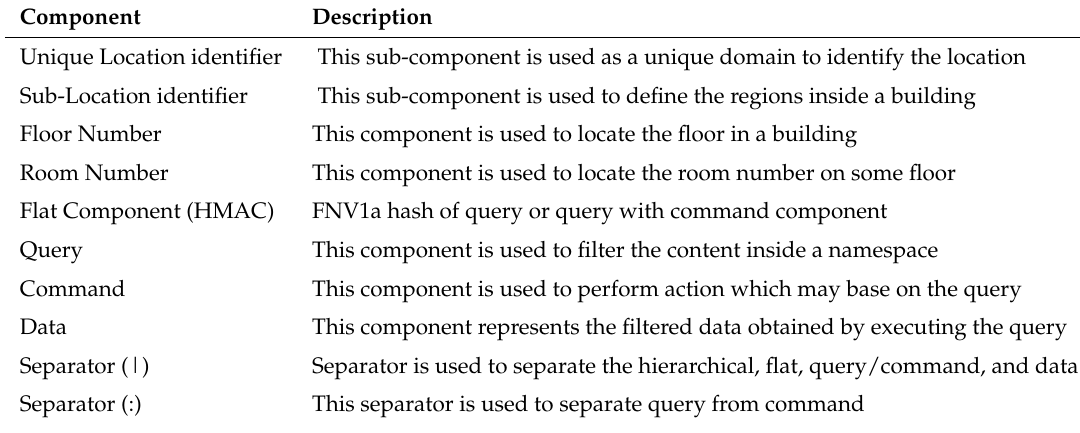
Figure 4. NINQ packet format. Table 2. Description of Packet